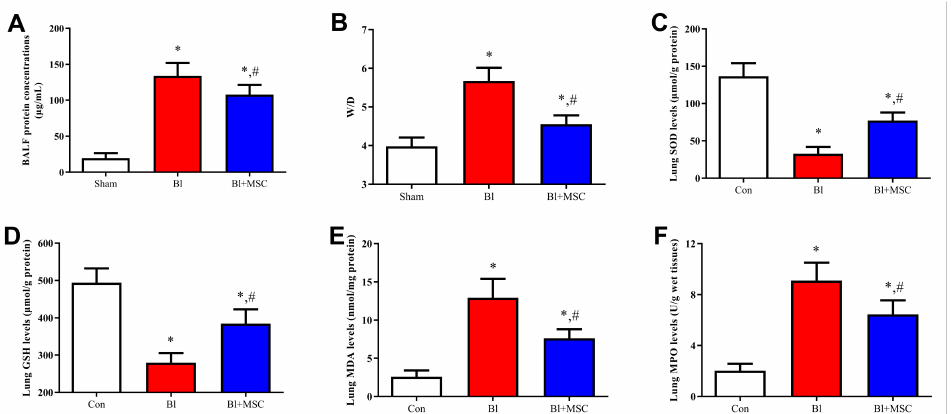
Figure 11. Effects of GMSCs on pulmonary oedema and oxidative stress-related indicators. ( A ) As- sessment of total protein in BALF. ( B ) Assessment of the wet/dry ratio in lung tissue. ( C ) Assessment of SOD expression in lung tissue. ( D ) Assessment of GSH content in lung tissue. ( E ) Assessment of MDA content in lung tissue. ( F ) Assessment of MPO expression in lung tissue. * p < 0.05 indicates significant differences versus the Con group; # p < 0.05 indicates significant differences versus the Bl group. Values are expressed as the mean ± SEM. Abbreviations: MDA, malondialdehyde; MPO, myeloperoxidase; GSH, glutathione; SOD, superoxide dismutase. White bars indicates Con group, red bars indicates Bl group, blue bars indicate Bl + MSC group.